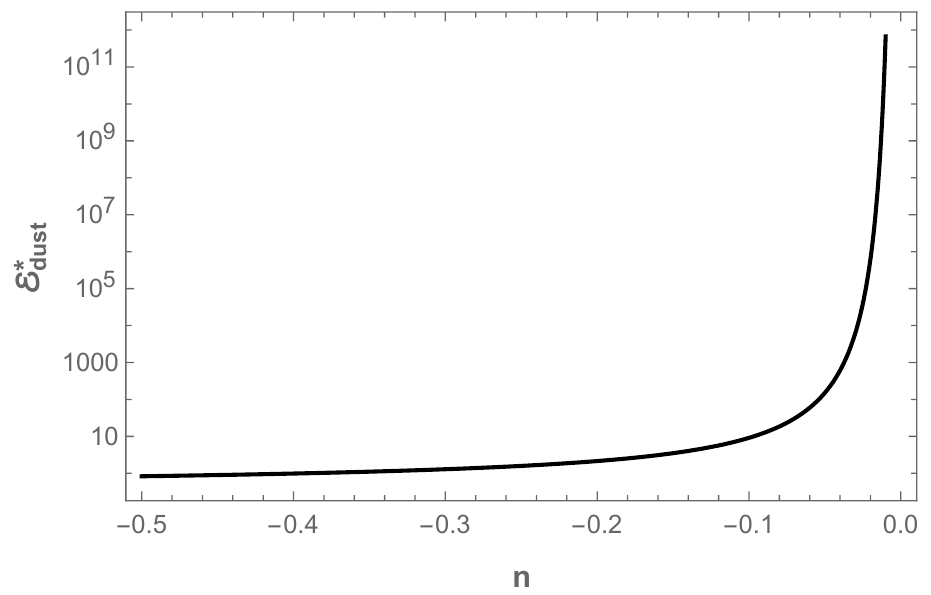
Figure 1. In the figure, we show the qualitative relationship between the threshold mass and the parameter n by assuming that µ n is numerically of a similar order as µ o ( n = 0) or λ ( n = − 1/2). To be specific, in the plot, we choose the numerical value of µ n the same as that of λ . The threshold mass for the formation of the trapped surface tends to be close to the Planck mass as n approaches − 1/2, and it approaches infinity when n approaches